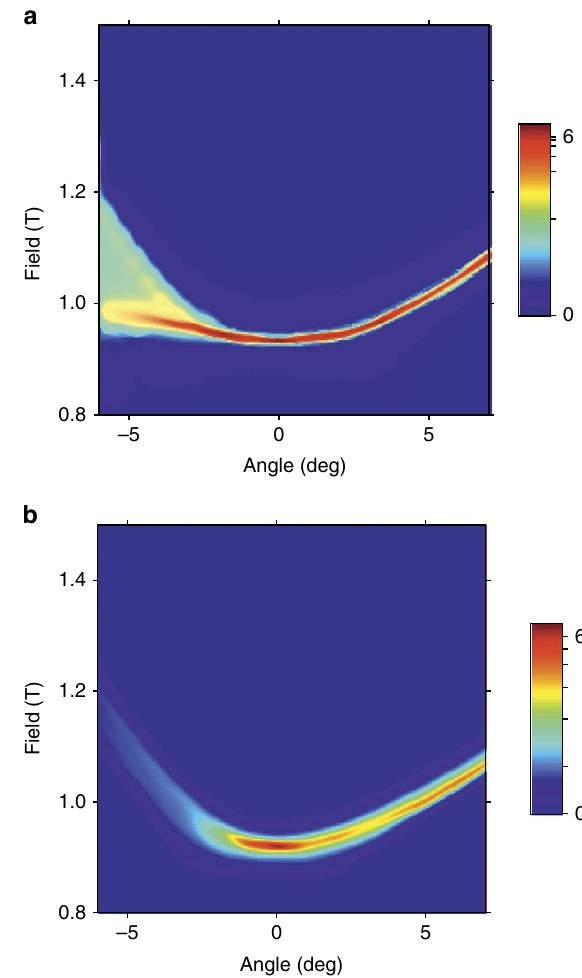
Figure 3 | Magnetic susceptibility from Monte Carlo simulations. ( a ) Contour plot of the susceptibility as extracted from the d-DSM, which shows a doubling of the transition and a marked anisotropy similar to that seen in the experiments (compare with previous data and ref. 26). ( b ) The best possible fit to the data achievable with the g-DSM. In both cases the colour scale is non-linear to avoid saturation from the high intensity